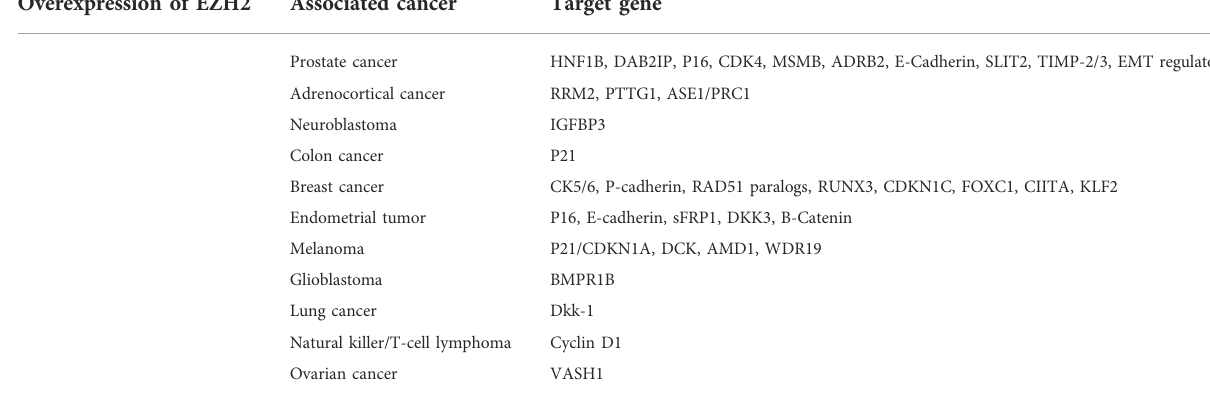
TABLE 1 EZH2 affected target genes in cancers. Overexpression of